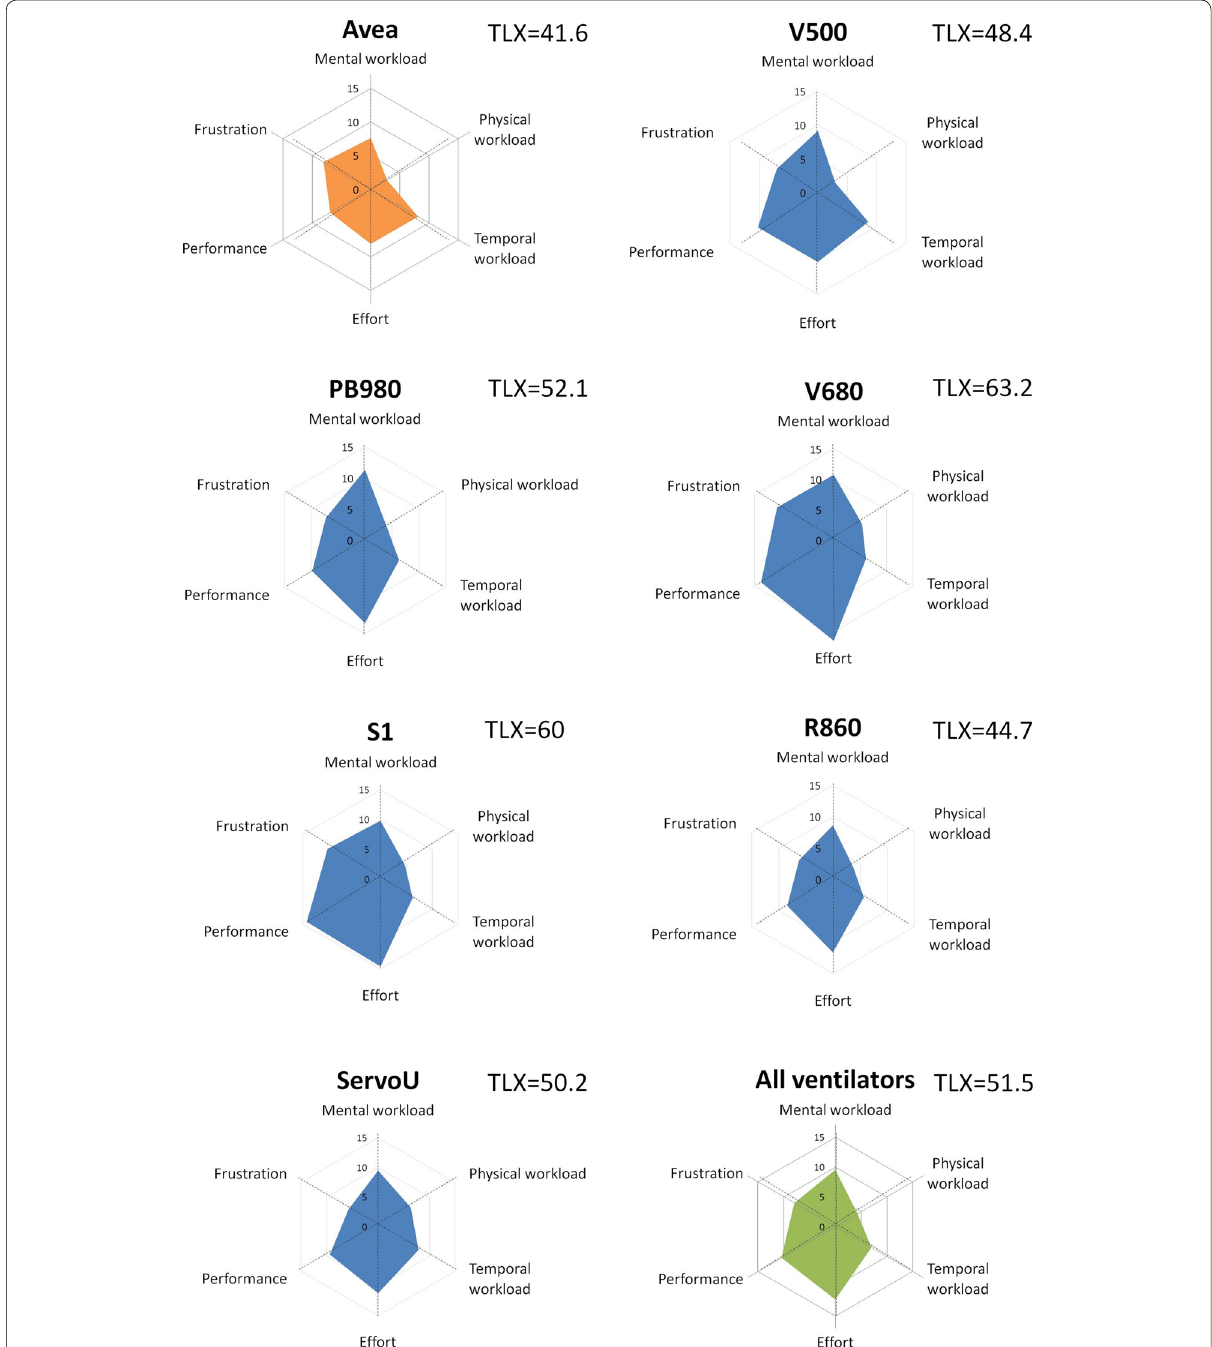
Fig. 6 Radar chart of National Aeronautics and Space Administration—Task Load Index for each ventilator. The radar chart of the NASA-TLX indi- cates both the overall mental workload evaluation (TLX value) and the different dimensions that are evaluated. Three dimensions are dependent on user perception of the task (mental workload, temporal workload and physical workload) and three dimensions dependent on the interaction between the subject and the task itself, which may be mostly related to the interface (effort, performance and frustration). The larger the area of the radar chart, the higher the TLX and thus the mental workload, and the lower the ergonomics. Values of the TLX score are indicated for each ventila- tor, our reference value being depicted in the upper left. Our reference value (Avea, in orange ) had the lowest mental workload value (TLX 41.6), = thus depicting the potential influence of experience on mental workload. For this reason, it is strictly mandatory to compare measurements per- formed on naïve subjects. R860 had the lowest TLX value, and V680 had the highest (* p 0.049). Dimensions of the mental workload that seemed = to require the most important improvements were performance and